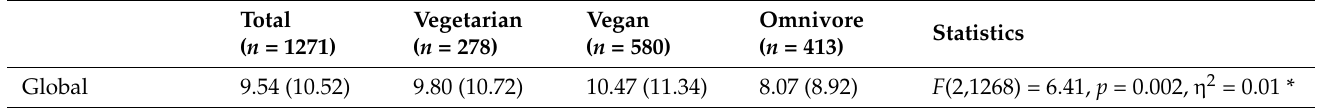
Table 1. Eating Attitudes Test (EAT) scores in vegetarians, vegans, and omnivores.